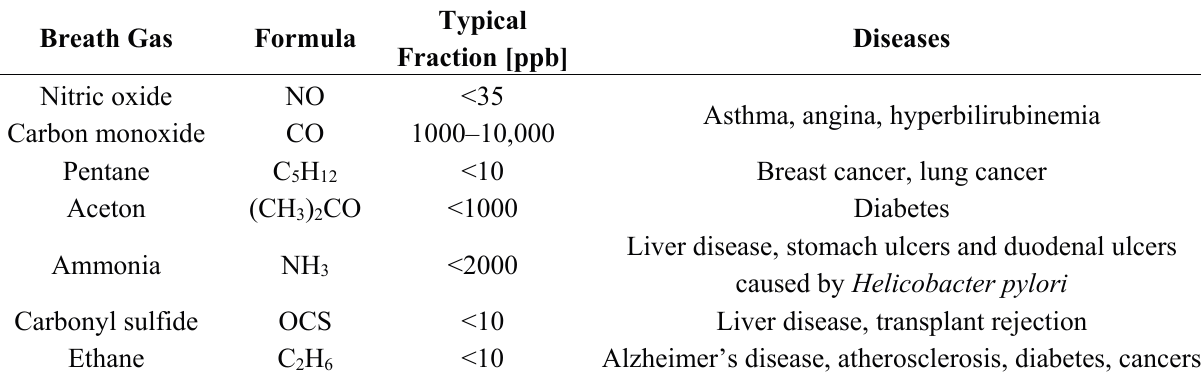
Table 1. Examples of disease